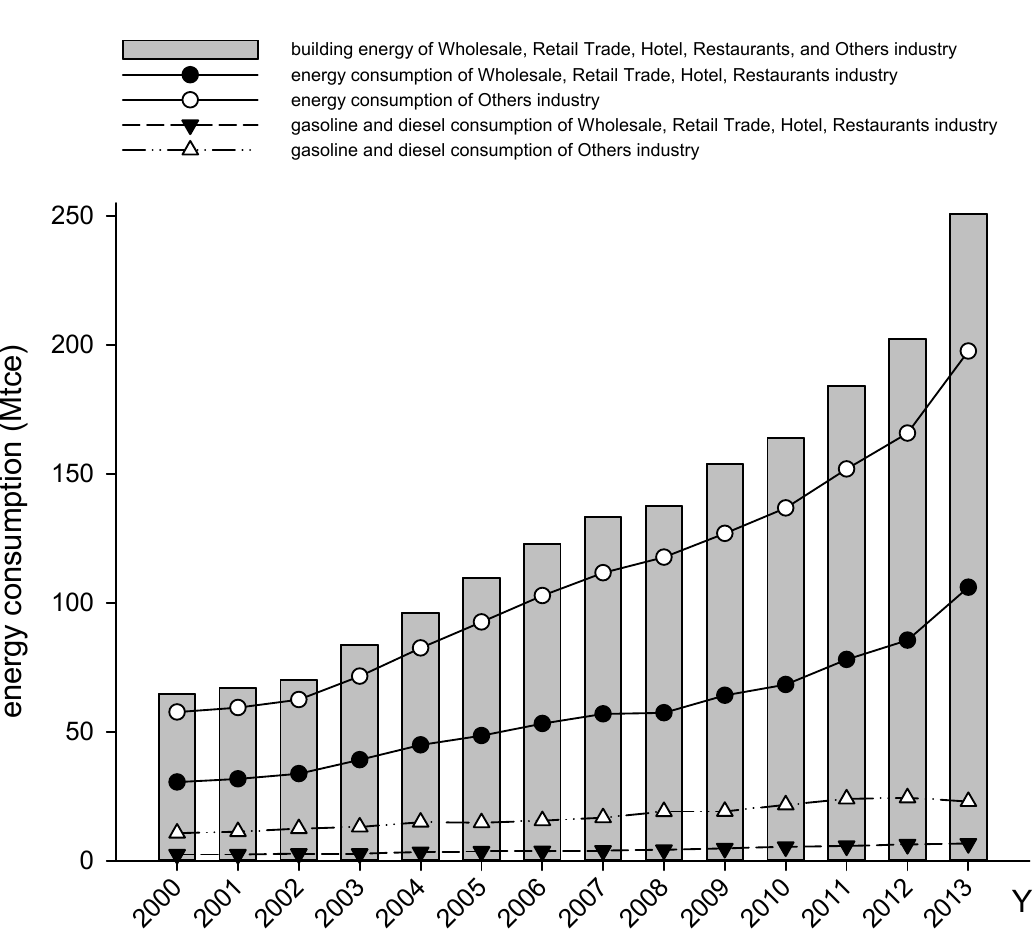
Figure 4. Energy consumption of Wholesale, Retail Trade, Hotel, Restaurants, and Other industries in China